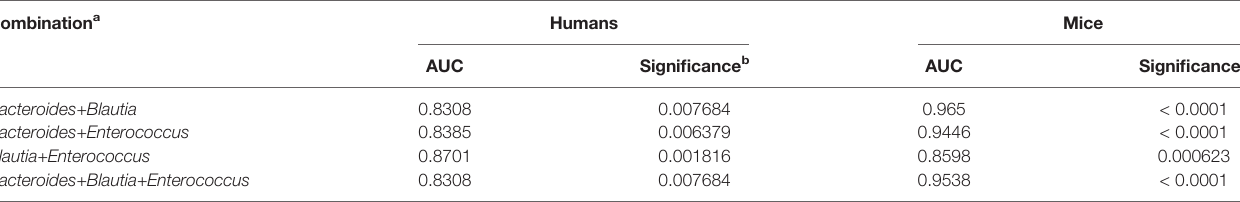
TABLE 1 | Receiver-operating characteristic (ROC) curves for the diagnosis of liver injuries using the combination of gut microbes. Combination